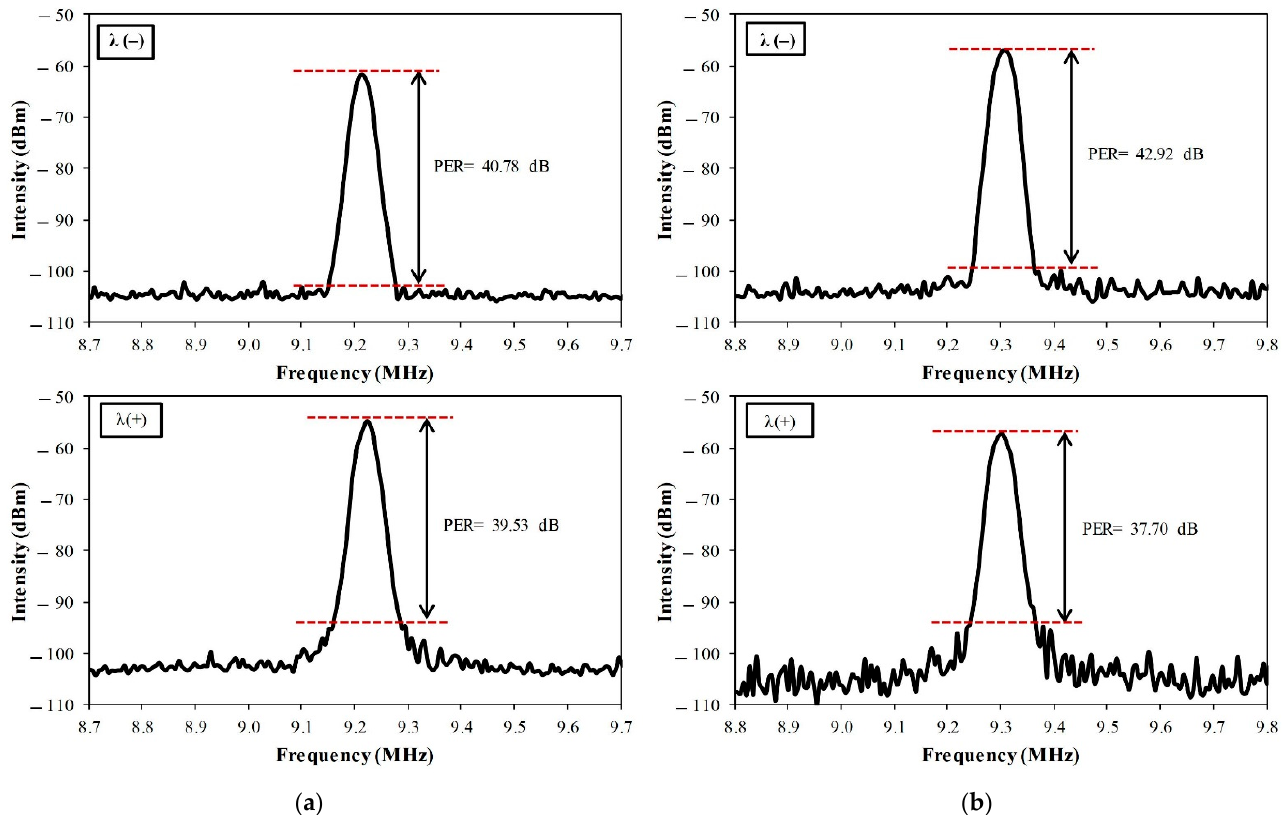
Figure 7. RF spectrum at fundamental frequency peak for ( a ) unidirectional DWML-EDFL and ( b ) bidirectional DWML-EDFL.